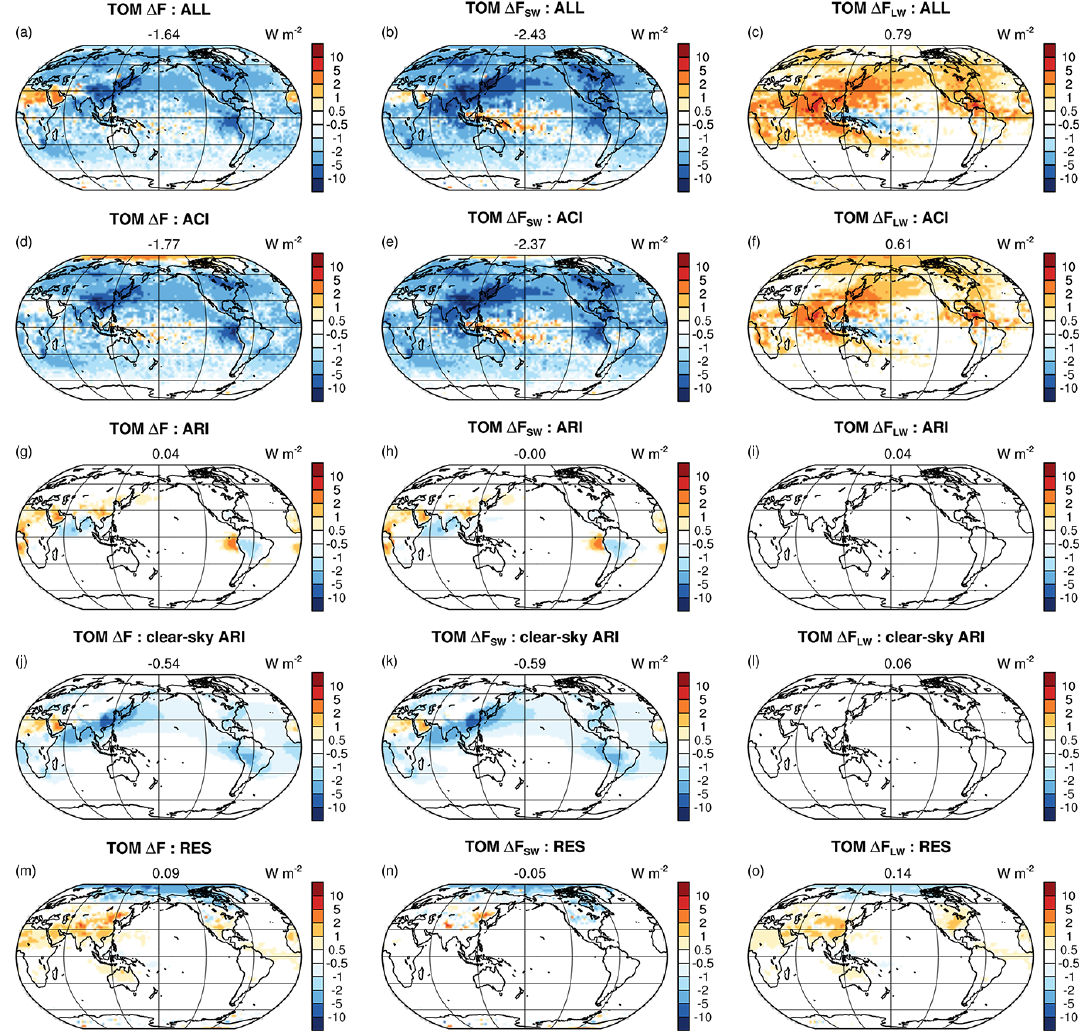
Figure 13. Geographical distributions of decomposed net (left column), shortwave (middle column), and longwave (right column) (cid:49) F at the top of the model (TOM). The decomposition calculation follows Ghan (2013). ALL indicates the total (cid:49) F calculated from the difference between CTRL and E1850 (ALL = ARI + ACI + RES). ACI indicates the (cid:49) F caused by aerosol–cloud interactions (second row), ARI the (cid:49) F caused by aerosol–radiation interactions (third row), and RES (bottom row) the residual forcing. The clear-sky direct aerosol effect (fourth row) is also shown. See Sect. 5.1 for